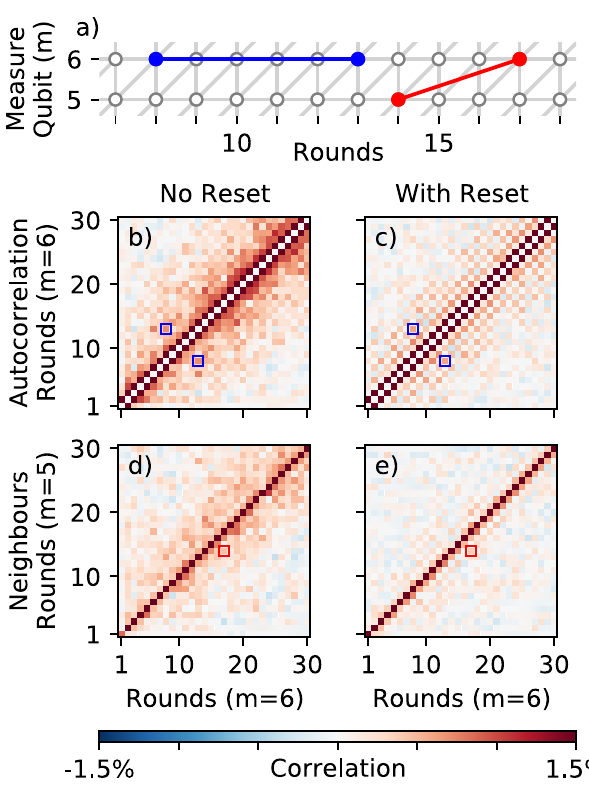
Fig. 5 Correlations caused by leakage. p ij matrices show the strength of non-local correlations in the detected errors. These undesired correlations are signi fi cantly reduced with the addition of reset. a The error graph for the bit- fl ip code, highlighting examples of non-local correlations on both space and time, indicating their corresponding p ij elements below (boxes). b , c Time-correlations on measure qubit 6, with and without reset. d , e Cross- correlations between measure qubits 5 and 6, with and without reset.